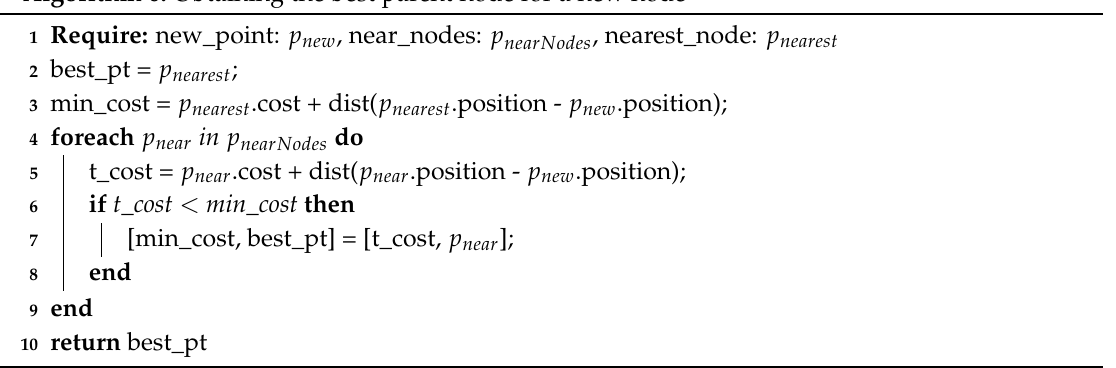
Algorithm 6: Obtaining the best parent node for a new